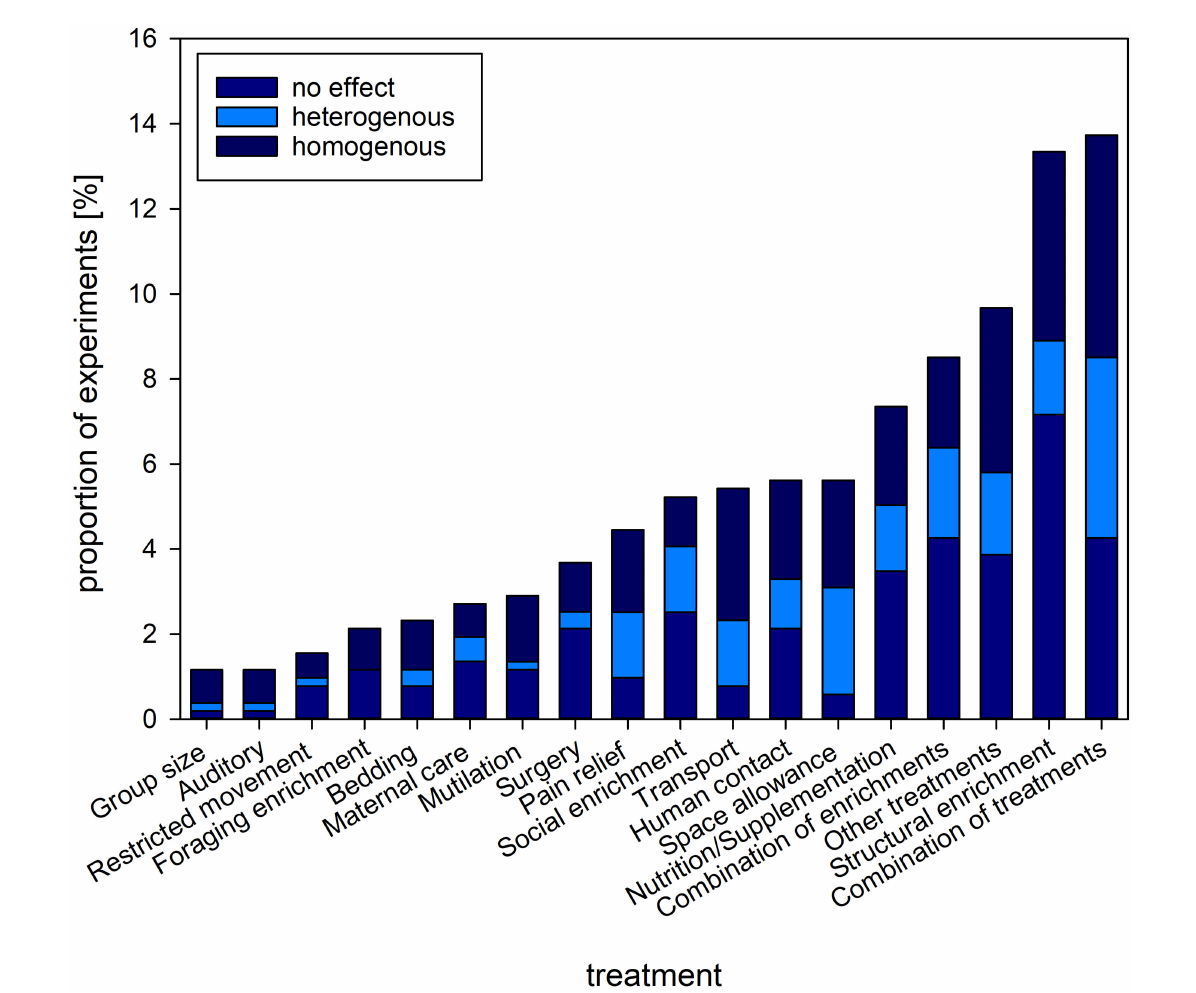
FIGURE6 Proportion [%] of experiments and the type of interventions investigated. Stacked bars refer to the proportion of experiments reporting on homogenous (consistent change in readout parameter compared to baseline/control), heterogenous (inconsistent change in readout parameter compared to baseline/control) or no effect of the intervention on GC levels. The figure shows the types of interventions with a proportion above 1% of the complete set of